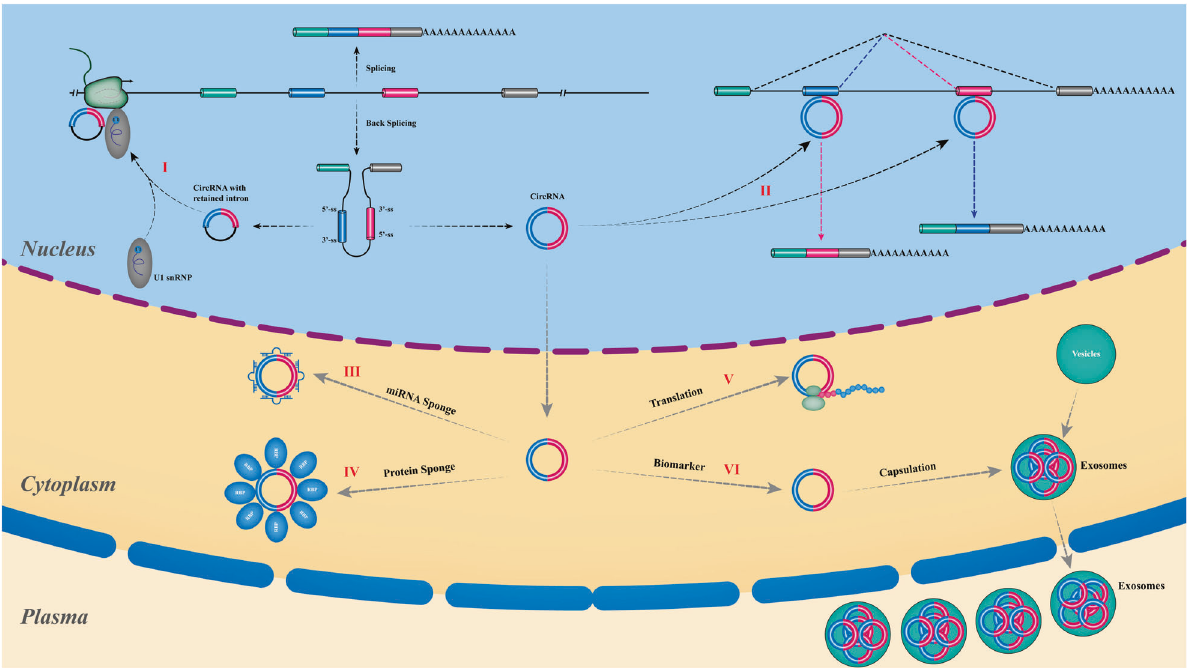
Fig. 2 Biogenesis and potential mechanisms of endogenous circRNAs in gene expression regulation. I: Regulation of parental genes transcription via combination with U1 RNP complexs; II: Modulating splicing of linear mRNA counterparts. III: Decoying miRNA as sponges. IV: Serving as scaffolds on which proteins assemble. V: Translating into peptides. VI: Secreted in exosomes that may serve as useful